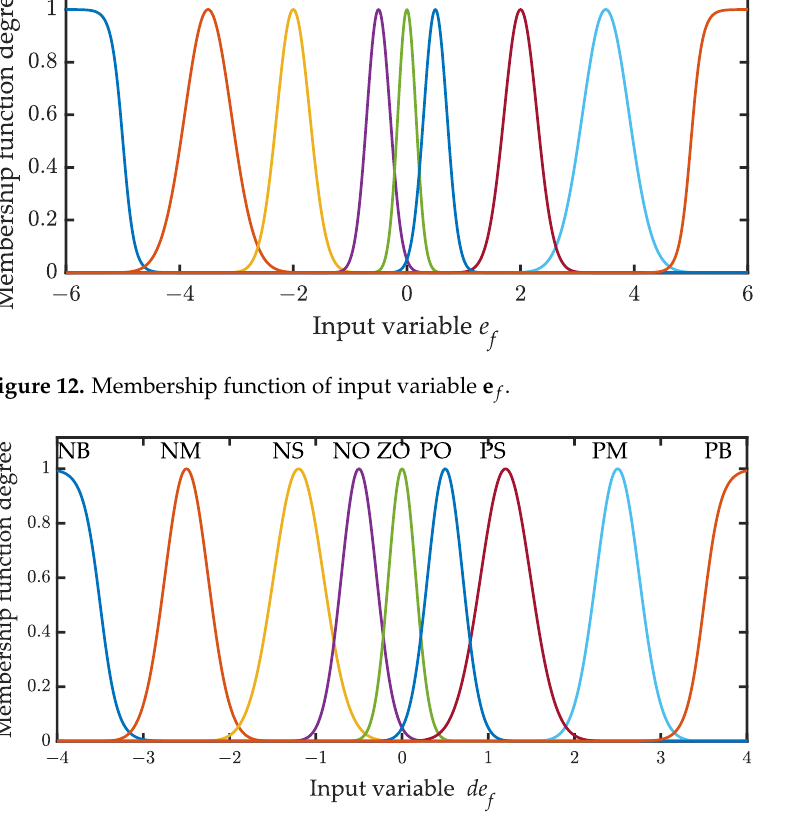
Figure 13. Membership function of input variable d